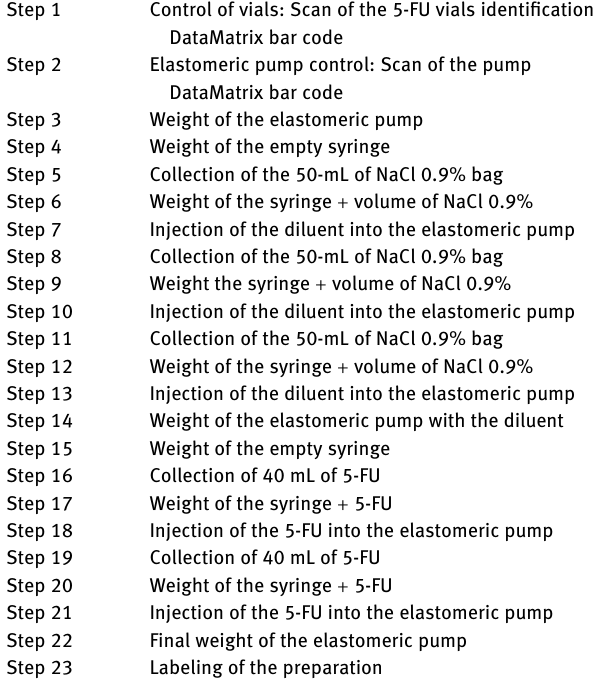
Table  : Steps necessary for the preparation of the elastomeric pump without the use of peristaltic pumps.